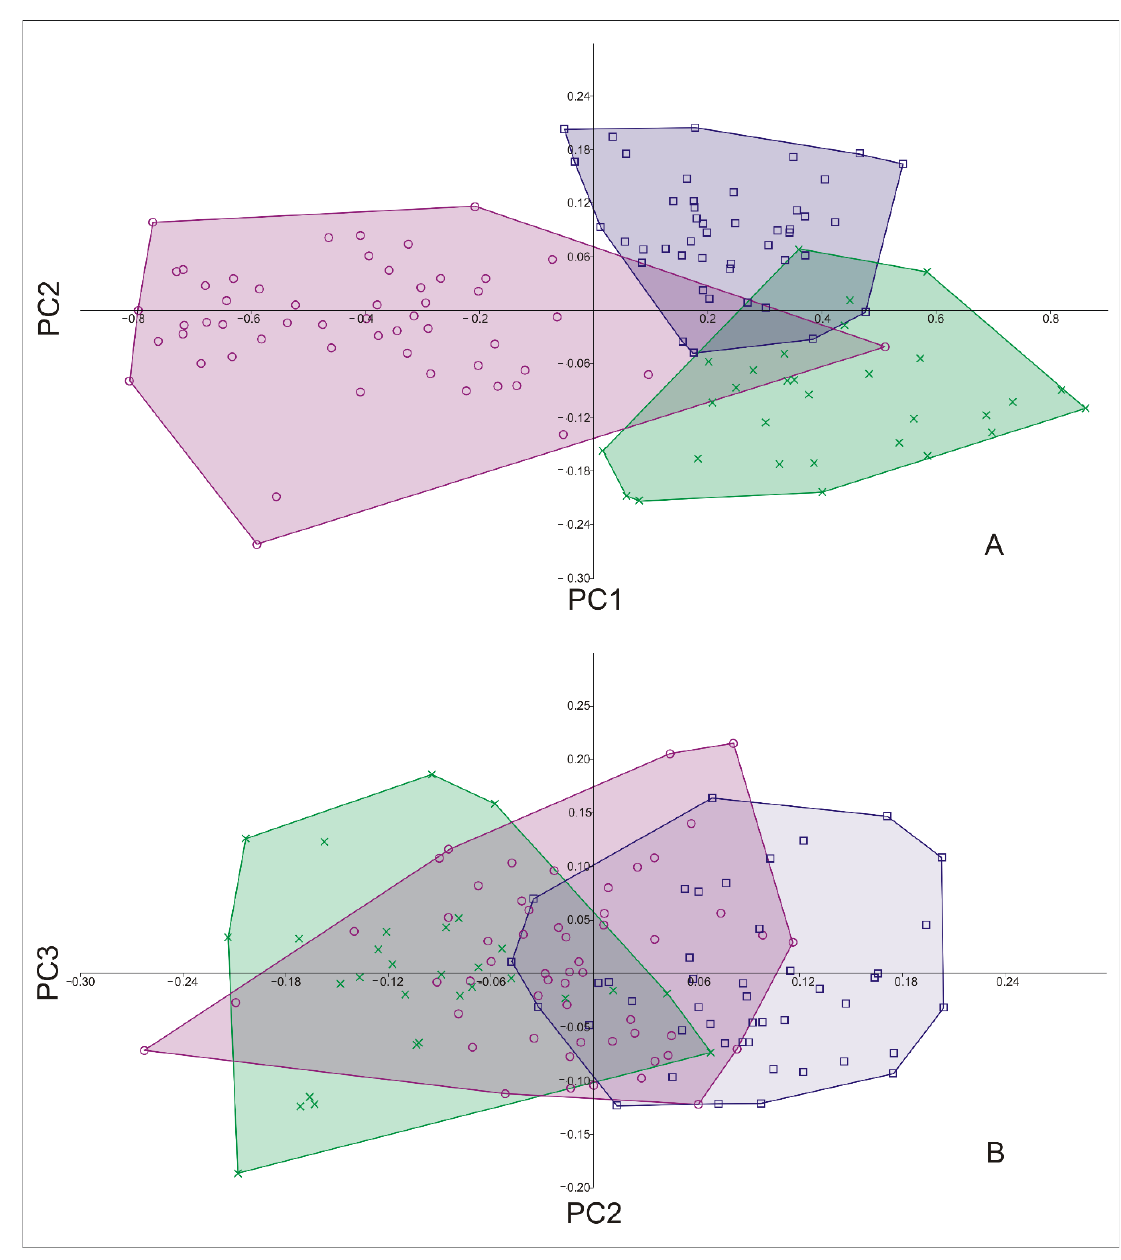
Figure 12. The results of the principal component analysis of shell measurements of three species of Clathrocaspia . The data of Table 2 were taken as the primary data. ( A ) — A scatter plot of individuals in the plane of the first two PCs. ( B ) — A scatter plot of individuals in the plane of the second and third PCs. The three first PCs explain 97.9% of the variation (PC1 – 90.0%; PC2 – 4.9%; PC3 – 3.0%). Purple color denotes C. laevigata sp. n., green denotes C. brotzkajae ; and blue denotes C. knipowitschii .